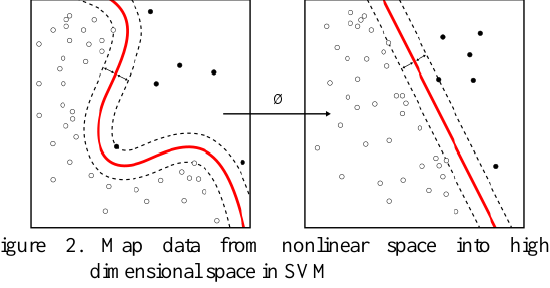
Figure 2. Map data from nonlinear space into higher dimensional space in